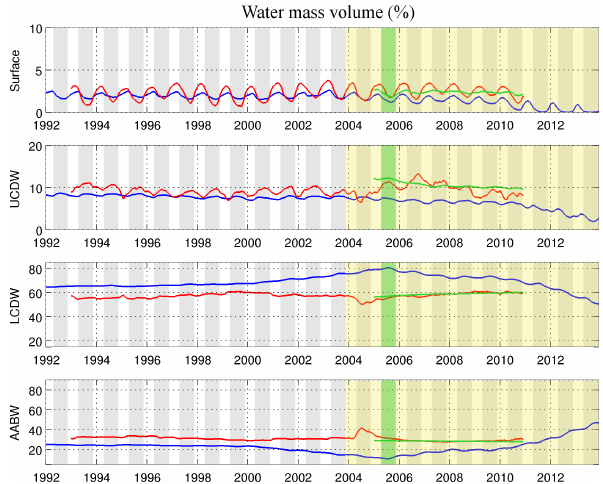
Figure 5. Same as Fig. 4 but for the Western Pacific sector. Figure 6. Same as Fig. 4 but for the Ross Sea sector.